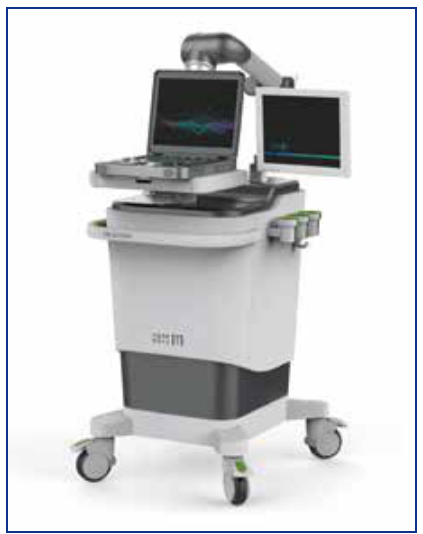
Figure 3 MGIUS-R3, a “fifth generation (5G) remote robotic US diagnostic” system synthesizing 5G, Robot technology, real-time remote control technology and Ultrasound, is developed by MGI, Shenzhen, China.